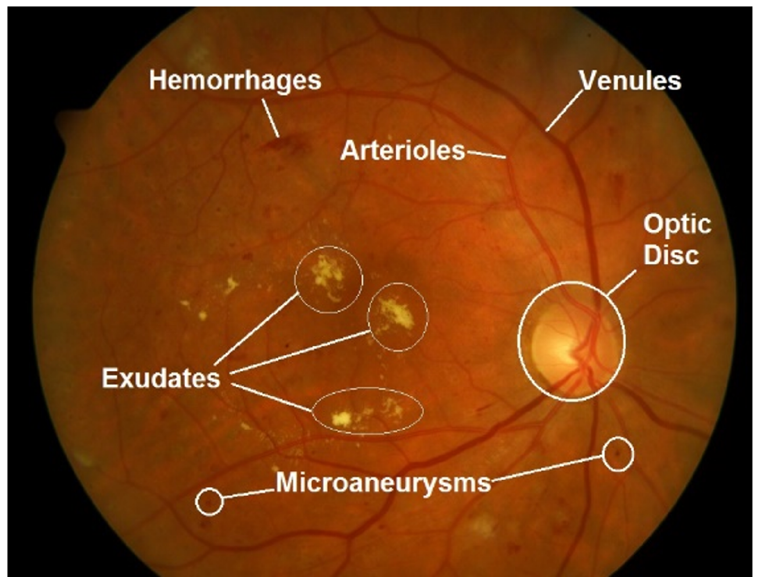
Figure 2. Retinal fundus image with marked main retinal features and abnormalities, typical signs of diabetic retinopathy (DR). Image source [21].